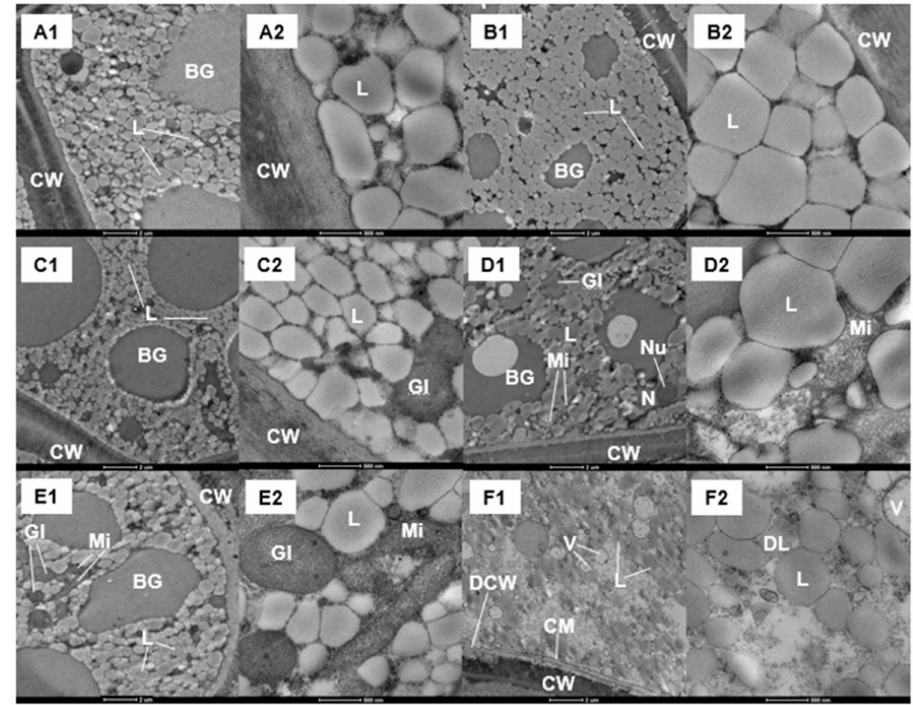
Figure 3. Changes of the subcellular structure of endosperm of carrot seeds after different priming treatments. ( A1 , A2 ) Two images from a CK seed endosperm before sowing; ( B1 , B2 ) Two images from a CK seed endosperm 20 h after sowing; ( C1 , C2 ) Two images from a HYD seed endosperm before sowing; ( D1 , D2 ) Two images from a HYD seed endosperm 20 h after sowing; ( E1 , E2 ) Two images from a HEHP seed endosperm before sowing; ( F1 , F2 ) Two images from a HEHP seed endosperm 20 h after sowing. ( A1 – F1 ) 4300 × . ( A2 – F2 ) 22,000 × . L: Oleosome; DL: Oleosome in the process of degradation; CW: Cell wall; DCW: Cell wall in the process of degradation; CM: Cell membrane; Mi: Mitochondrion; Gl: Glyoxysome; V: Vesicle; N: Nucleus; Nu: Nucleolus; BG: High electron dense